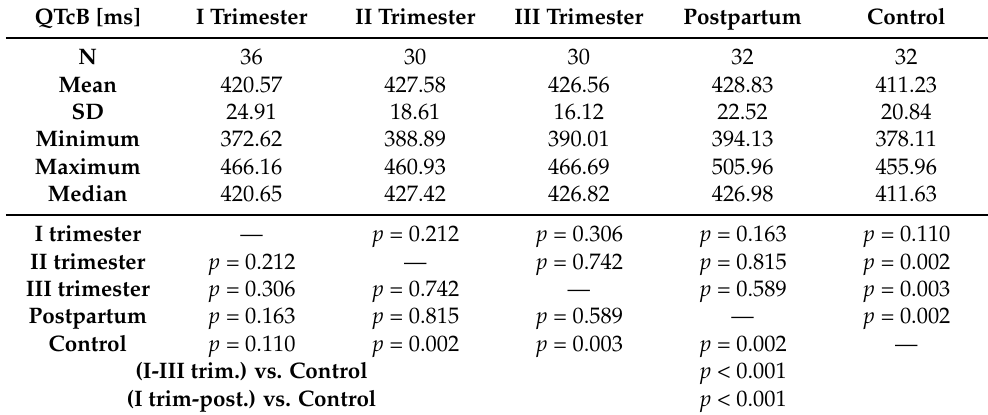
Figure 2. QTc interval in women in the 1st, 2nd, and 3rd trimester of pregnancy, in the puerperium and in the control group. Table 1. QTcB in women in the 1st, 2nd and 3rd trimester of pregnancy, in the puerperium and in the control group.